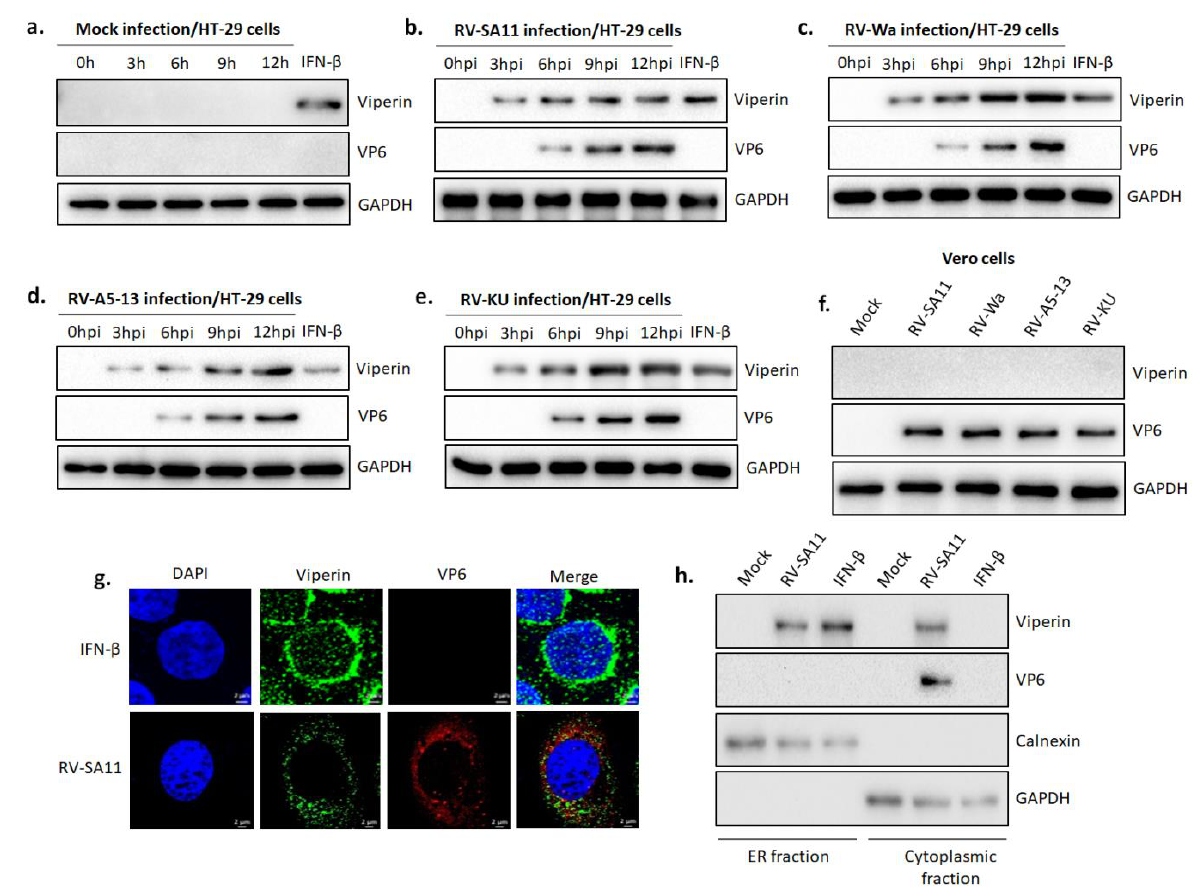
Figure 1. Viperin expression was triggered during RV infection. HT-29 cells were either ( a ) mock infected or infected with ( b ) RV-SA11, ( c ) RV-Wa, ( d ) RV-A5-13 or ( e ) RV-KU at an MOI of 3 and incubated until the indicated time points post-infection. Next, cell lysates were prepared and subjected to SDS-PAGE/western blot analysis using antibodies specific for viperin, VP6 and GAPDH. VP6 and GAPDH served the purpose of the infection marker and the internal loading control, respectively. ( f ) Vero cells, attenuated for type-I IFN production, were either mock infected or infected with RV-SA11, RV-Wa, RV-A5-13 or RV-KU at an MOI of 3 and incubated for 12 hpi. Subsequently, viperin expression was assessed in whole cell lysates by western blot using anti-viperin, anti-VP6 and anti-GAPDH antibodies. ( g ) HT-29 cells were either infected with RV-SA11 for 9 h or treated with IFN- β for 6 h. Next, cells were fixed, permeabilized and stained with primary antibodies specific for viperin and VP6. Secondary staining was performed with Rhodamin-labeled anti-mouse (for VP6) and Dylight488-labeled anti-rabbit (for viperin) antibodies. DAPI was used for mounting. Imaging was performed with a confocal microscope (63X oil immersion). Images were processed with Zen Blue software. Scale bar, 2 μm. ( h ) ER and cytosolic fractions of HT-29 cells, either mock infected or infected with RV-SA11 for 9 h, were subjected to SDS-PAGE/western blot analysis to evaluate the expression of viperin, VP6, calnexin and GAPDH. Calnexin and GAPDH served the purpose of the ER marker and the cytoplasmic marker,